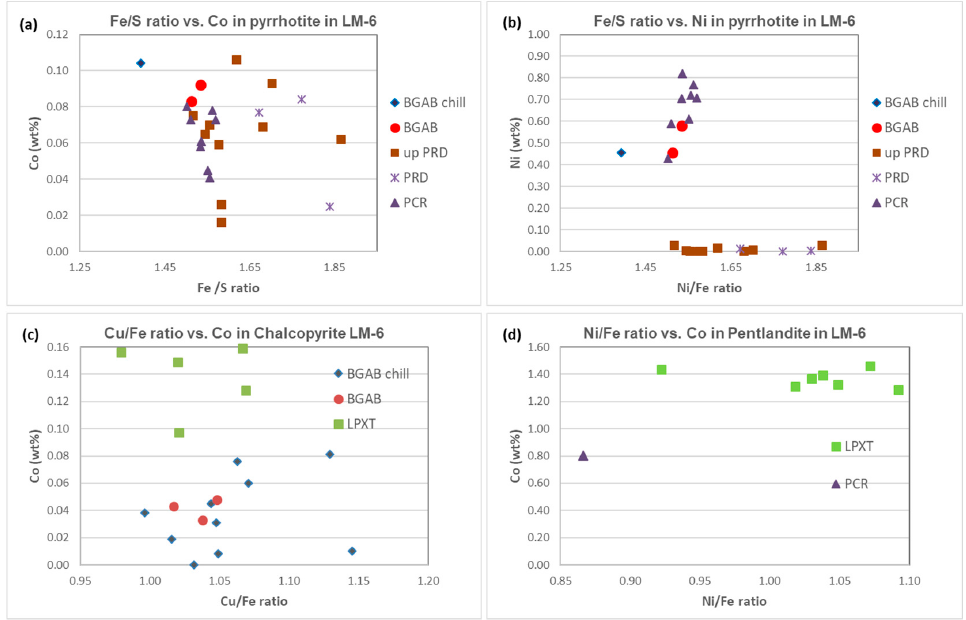
Figure 13. Pyrrhotite ( a,b ), chalcopyrite ( c ) and pentlandite ( d ) compositional data of the lower Uitkomst Complex in drill core LM-6.